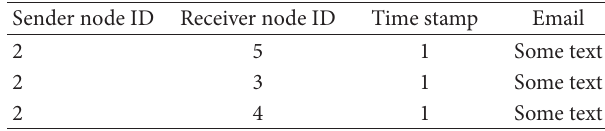
Table 2: Email database.